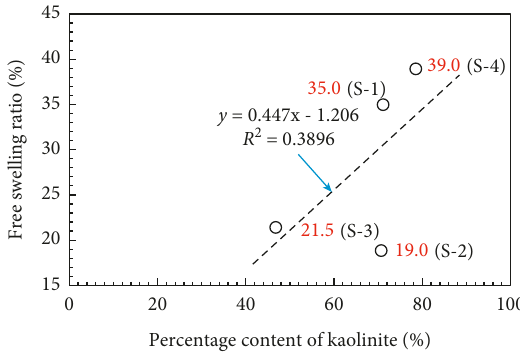
Figure 6: Relationship between kaolinite content and free swelling ratio of lateritic